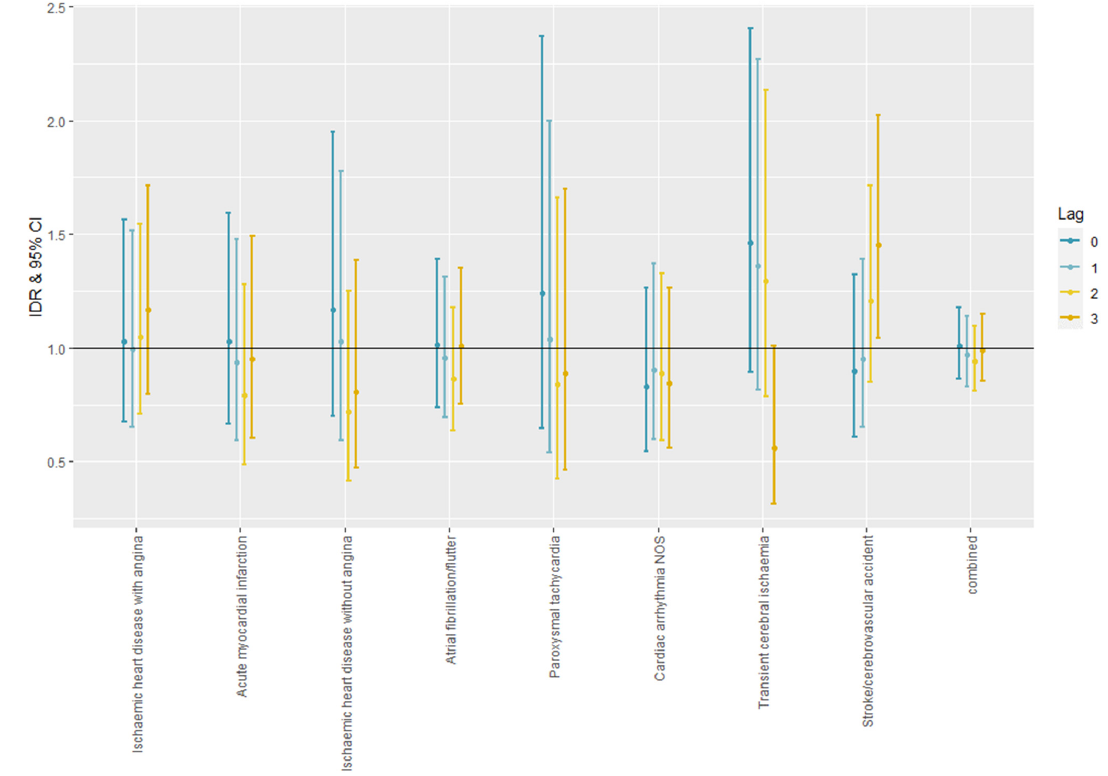
Figure 3. The IDRs with 95% CI for cardiovascular morbidities.